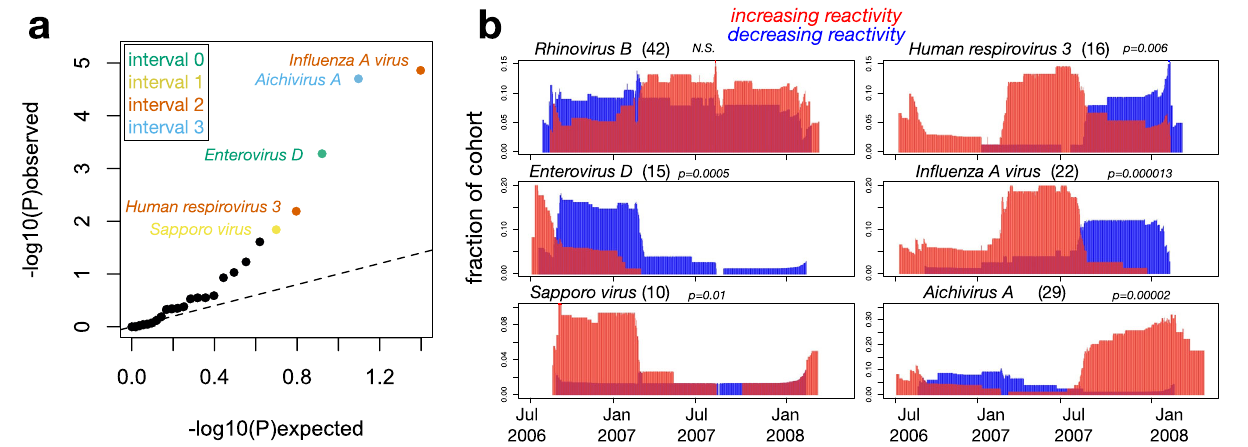
Fig.3|Seasonalityanalysisrevealsepidemicwavesforasubsetofviralspecies. a For each species, the viral events detected across the cohort described in Fig. 2 were localized to one of the sampling 6-monthly intervals, and seasonal effects were quanti fi ed by comparing the observed distributions against a one-sided multinomial model in which events were distributed across intervals with equal probability. Shown is a quantile-quantile plot of unadjusted − log10(probabilities) for each of 25 species for which ≥ 5 total events were observed across the cohort. The fi ve species with FDR-adjusted p values <0.1 are highlighted and colored according to the interval in which their event count is maximum. b For the fi ve signi fi cant species identi fi edin ( a ), and Rhinovirus B asa negative control,pro fi les